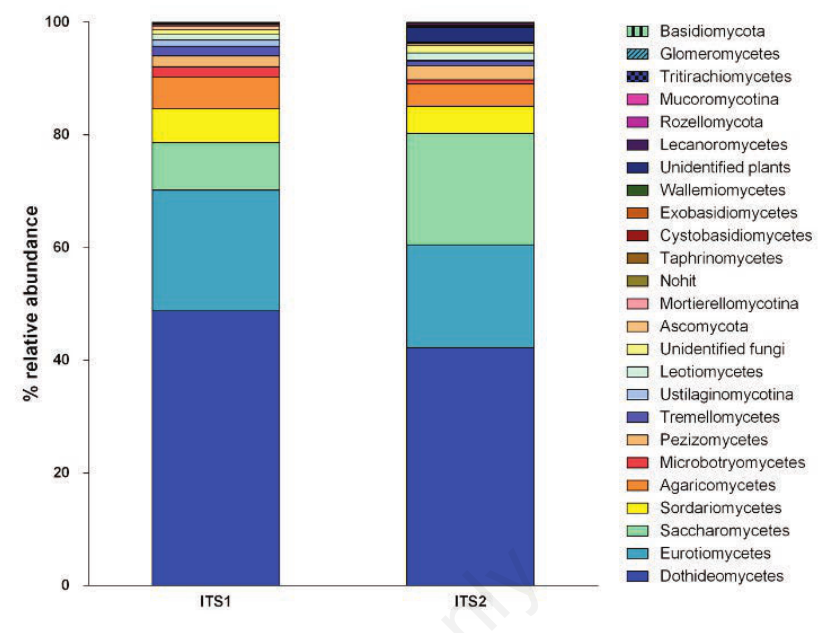
Figure 1. Relative abundance of the classes of fungi detected in the three environments (compost, biomethanization and dairy farms). Samples were compared based on the bar- code used. The Blastn tool and the UNITE database were used for taxonomy assignment.